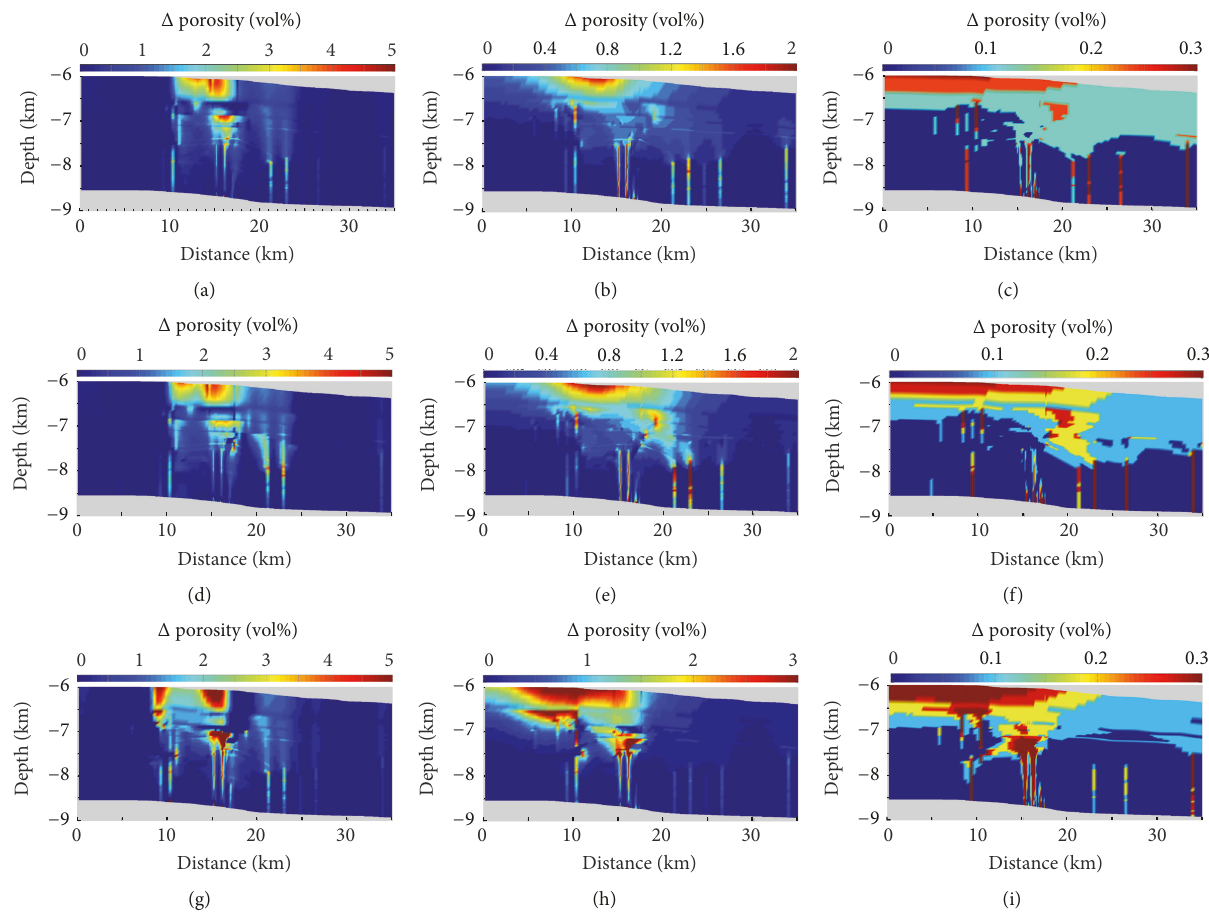
Figure 15: The dolomite dissolution patterns simulated for an interval of 10Ma for Scenario I: (a) 𝑘 h : 𝑘 v = 1 , (b) 𝑘 h : 𝑘 v = 10 , and (c) 𝑘 𝑘 = 100 ; Scenario II: (d) 𝑘 h : v (i) 𝑘 h : 𝑘 v = 100 . The plotting area is referred to the model domain below dashed lines in Figure 11 which is mainly composed of dolomite